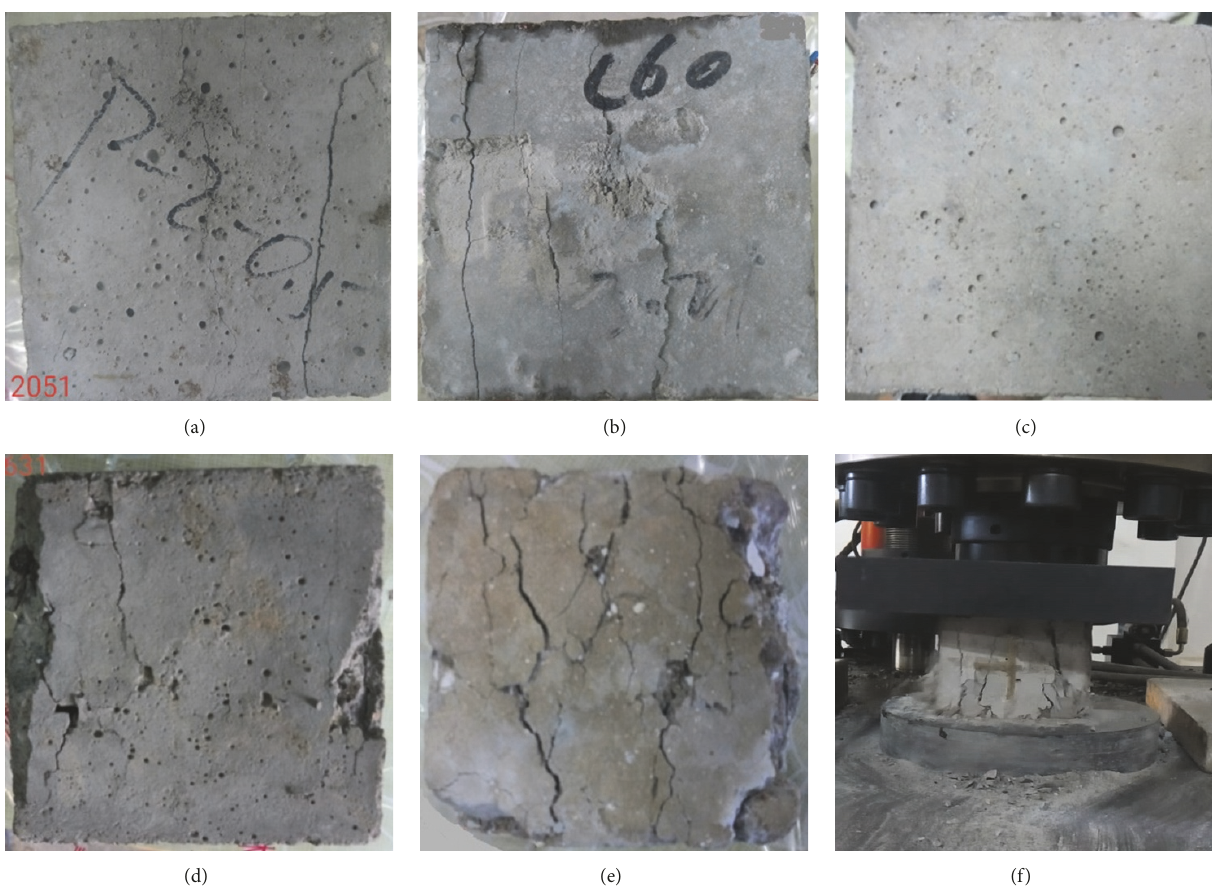
Figure 3: Failure mode of HSC specimens under uniaxial compression loads after different high temperature processes: (a) P-2-0.5, 𝑆 max = 0.80, 0. 5𝑁 𝑓 ; (b) P-2-3, 𝑆 max = 0.85, 0. 5𝑁 𝑓 ; (c) P-5-0.5, 𝑆 max = 0.90, 0.25 𝑁 𝑓 ; (d) P-6-3, 𝑆 max = 0.85, 0.75 𝑁 𝑓 ; (e) P-8-2, 𝑆 max = 0.90, 𝑁 𝑓 ; (f) critical failure state of fatigue.